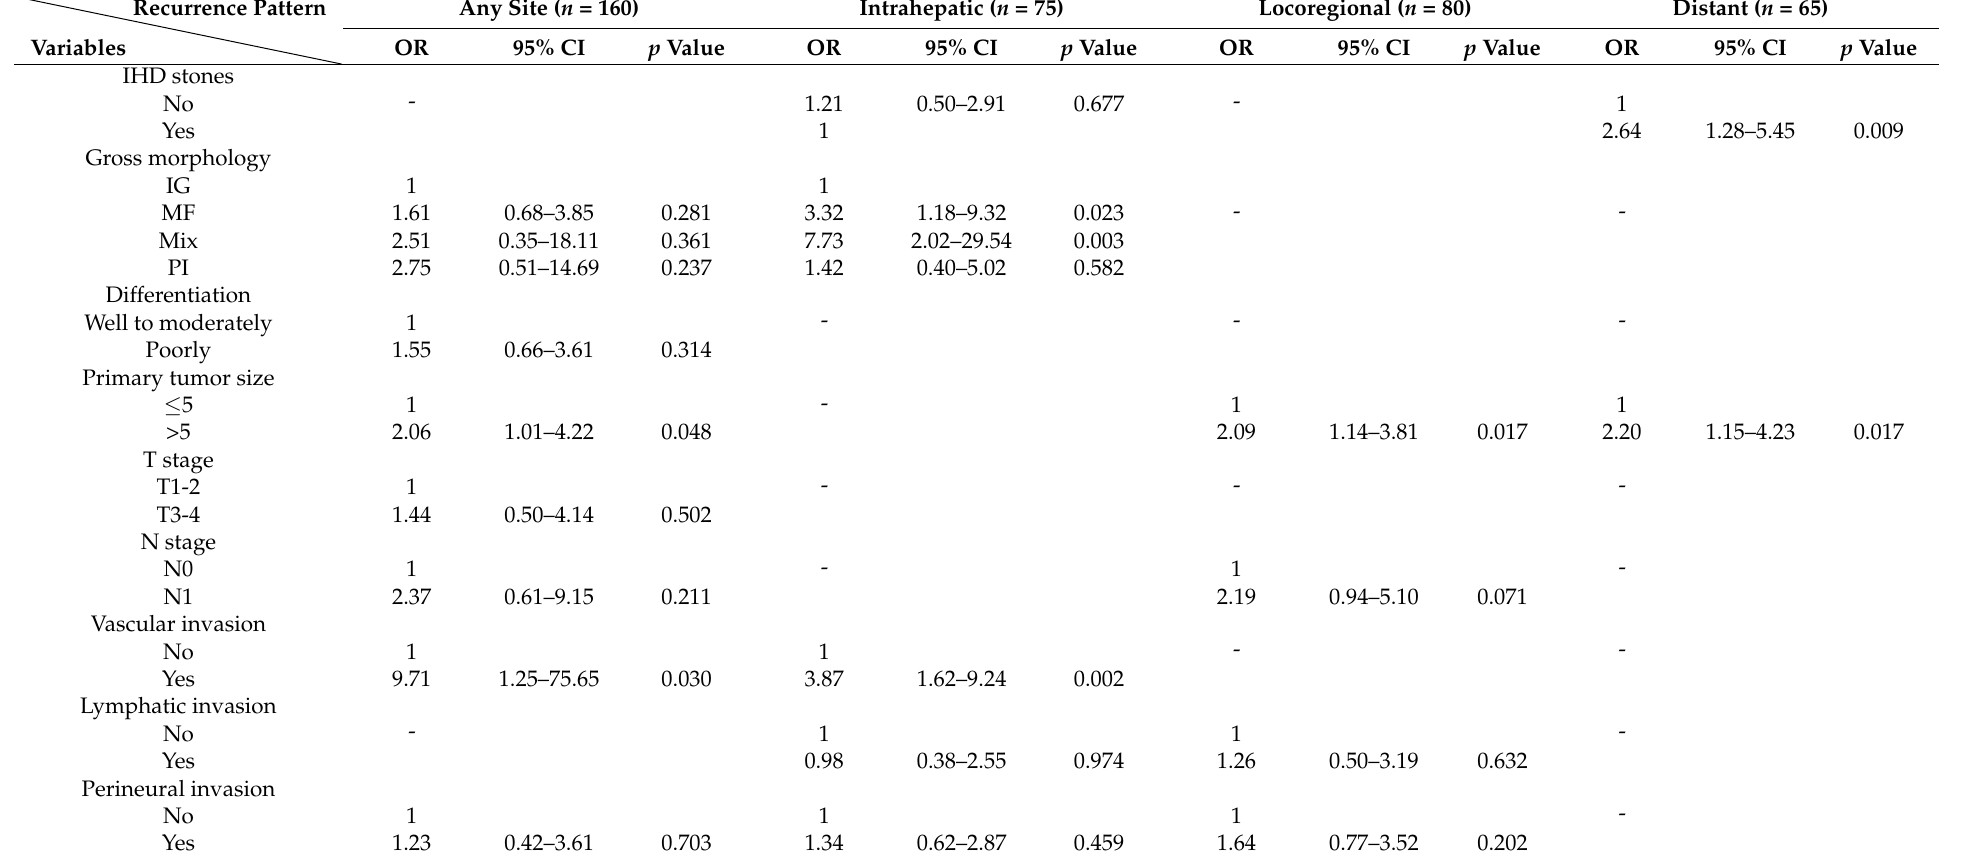
Table 3. Multivariate logistic regression model to predict risk factors for different recurrence